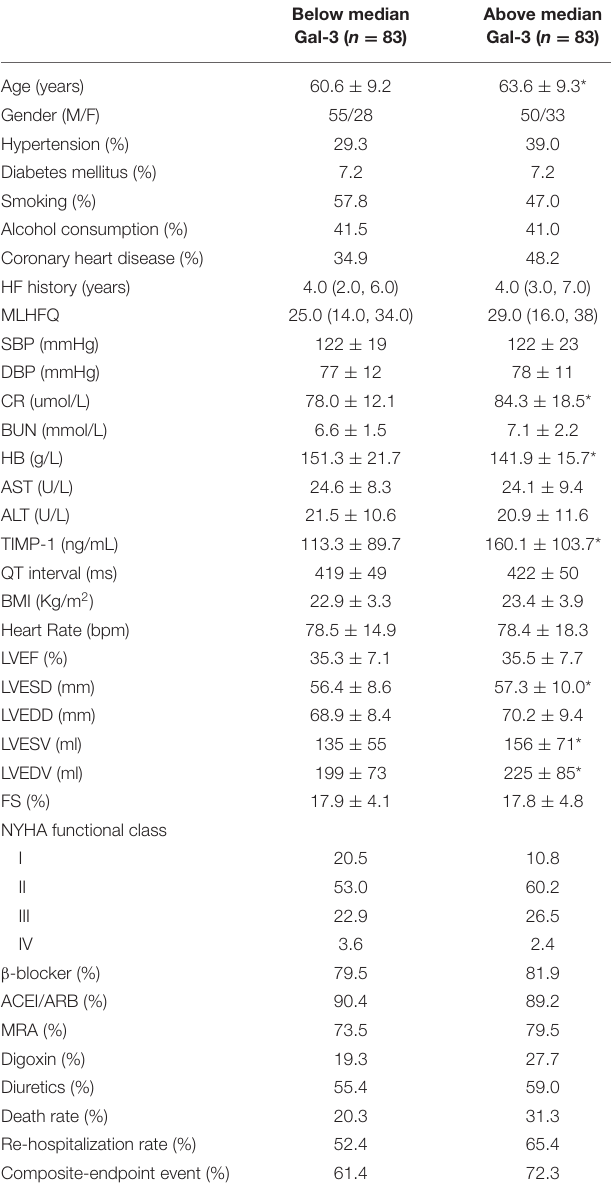
TABLE 1 | Baseline characteristics of all HFrEF